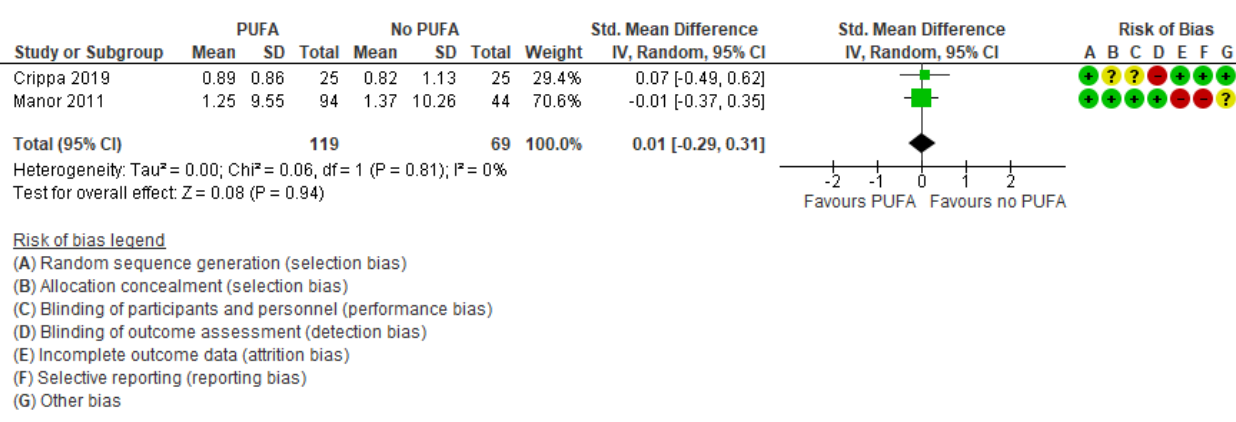
Figure 7. Forest plot of comparison: PUFA vs. placebo, outcome: quality of life (longest follow-up time (minimum 3 months after end of treatment)). Green square indicates summary estimates of the individual studies. Black diamond indicates total summary effect estimate.